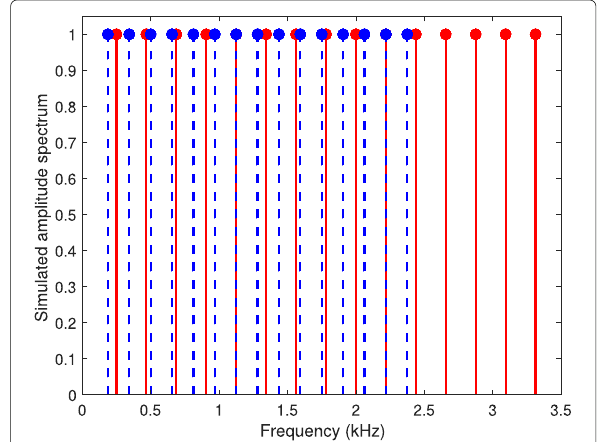
Fig. 1 Simulated amplitude spectrum of two spatially separated sources